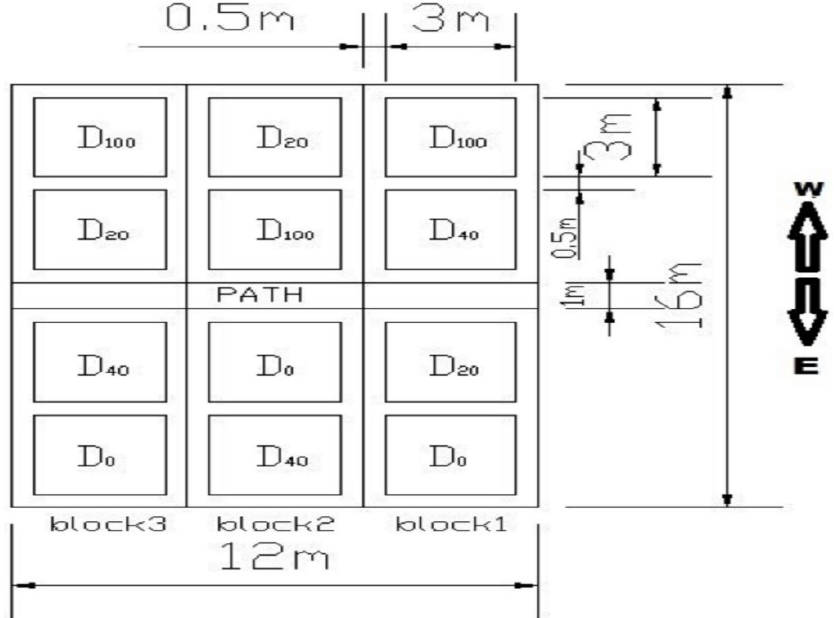
Figure 2. Experimental field layout.